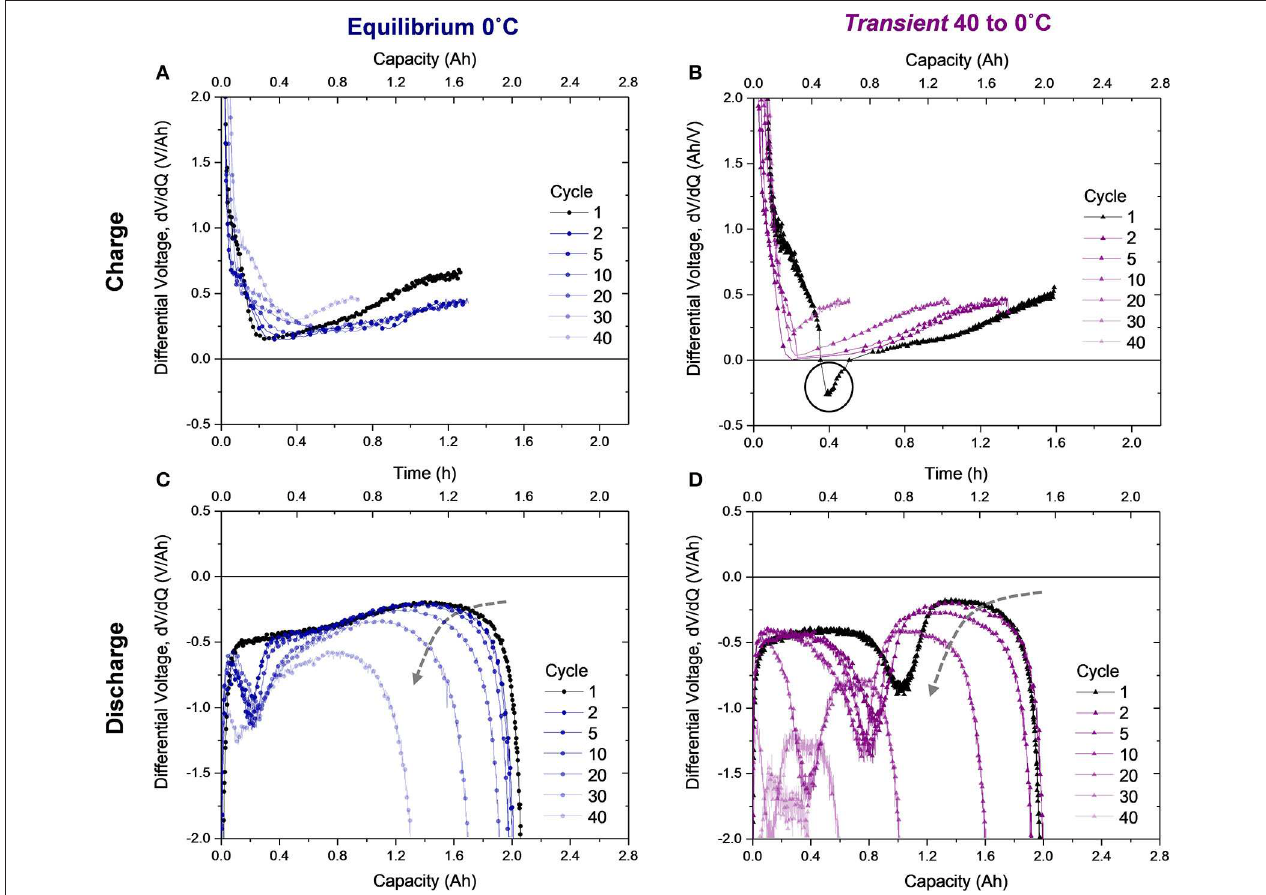
FIGURE 5 | Differential voltage from select charges (1, 2, 5, 10, 20, 30, and 40) of the (A) Equilibrium 0 ◦ C cell and (B) Transient 40 to 0 ◦ C cell and differential voltage of their subsequent discharges, (C,D) , respectively. The dashed arrow in (C,D) shows the trend of decreasing average differential voltage during deintercalation which correlates to jellyroll